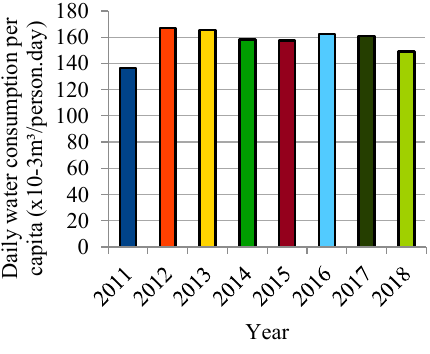
Figure 6. Average daily consumption per capita, based on annual consumption data (it does not include water consumption in toilets).